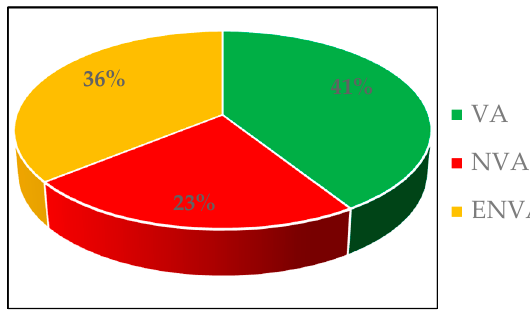
Figure 2. Summary of the VSM data of the process “cutting tile”.